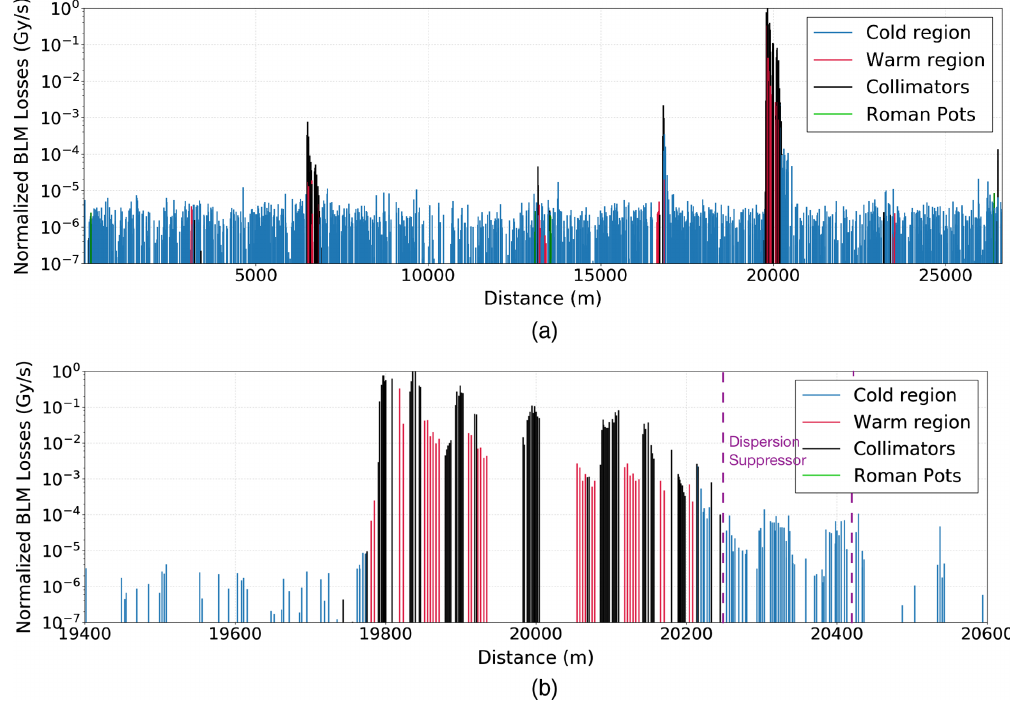
FIG. 4. An example of a beam 1 betatron horizontal loss map at 6.5 TeV, where the data points are readings taken from BLM detectors in (a) all IRs, and (b) IR7, highlighting the cleaning inefficiency in the dispersion